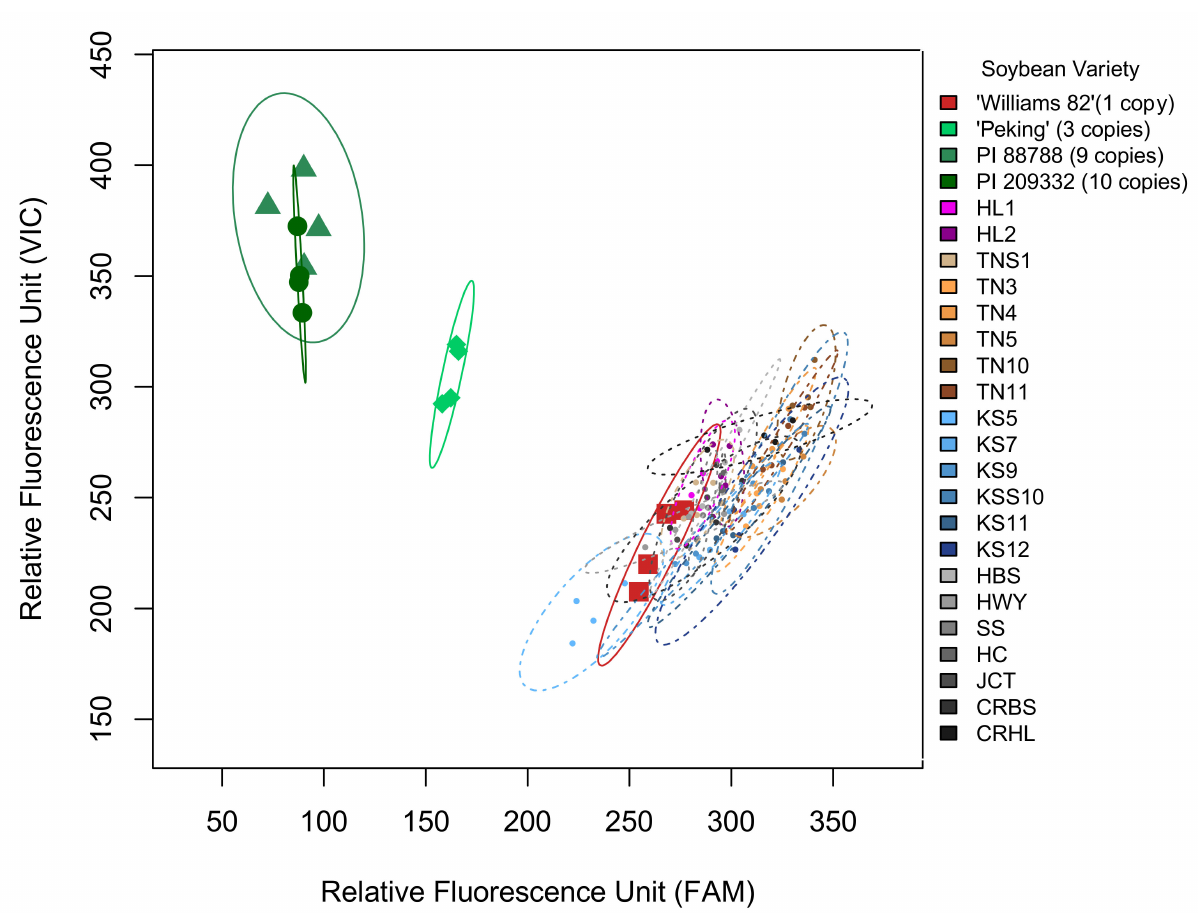
Figure 1. Detection of relative fluorescence unit (RFU) among soybeans with different copy numbers of rhg1 locus. ‘Williams 82’ served as the susceptible soybean variety, which contains only one copy number of rhg1 locus. ‘Peking’, PI 88788, and PI 209332 served as the resistant soybean varieties, which contain three, nine, and ten copy numbers of rhg1 locus. All soybean varieties developed in Taiwan were measured to have RFUs undistinguishable from ‘Williams 82’. Each data point was averaged from three technical replicates in the qPCR measurement. Each variety was represented by four biological replicates, which included five plants in one DNA extraction; in other words, the four data points of each variety were represented by a total of 20 soybean plants. The ‘Williams 82’, ‘Peking’, and PI 209332 were measured in every plate as a control, and therefore, 16 data points were shown in the plot. The ellipse circles exhibit the 95% confidence interval for different soybean